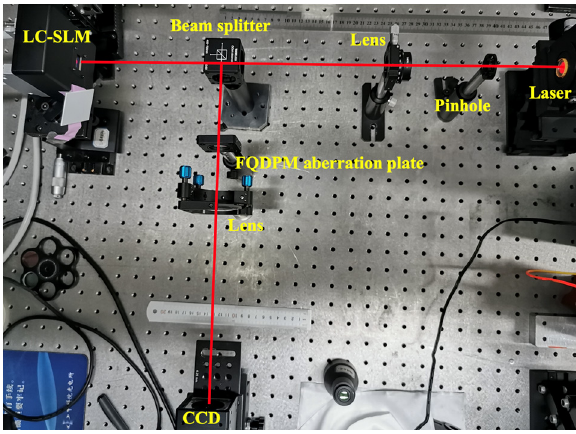
Figure 7. Schematic diagram of a real optical path.